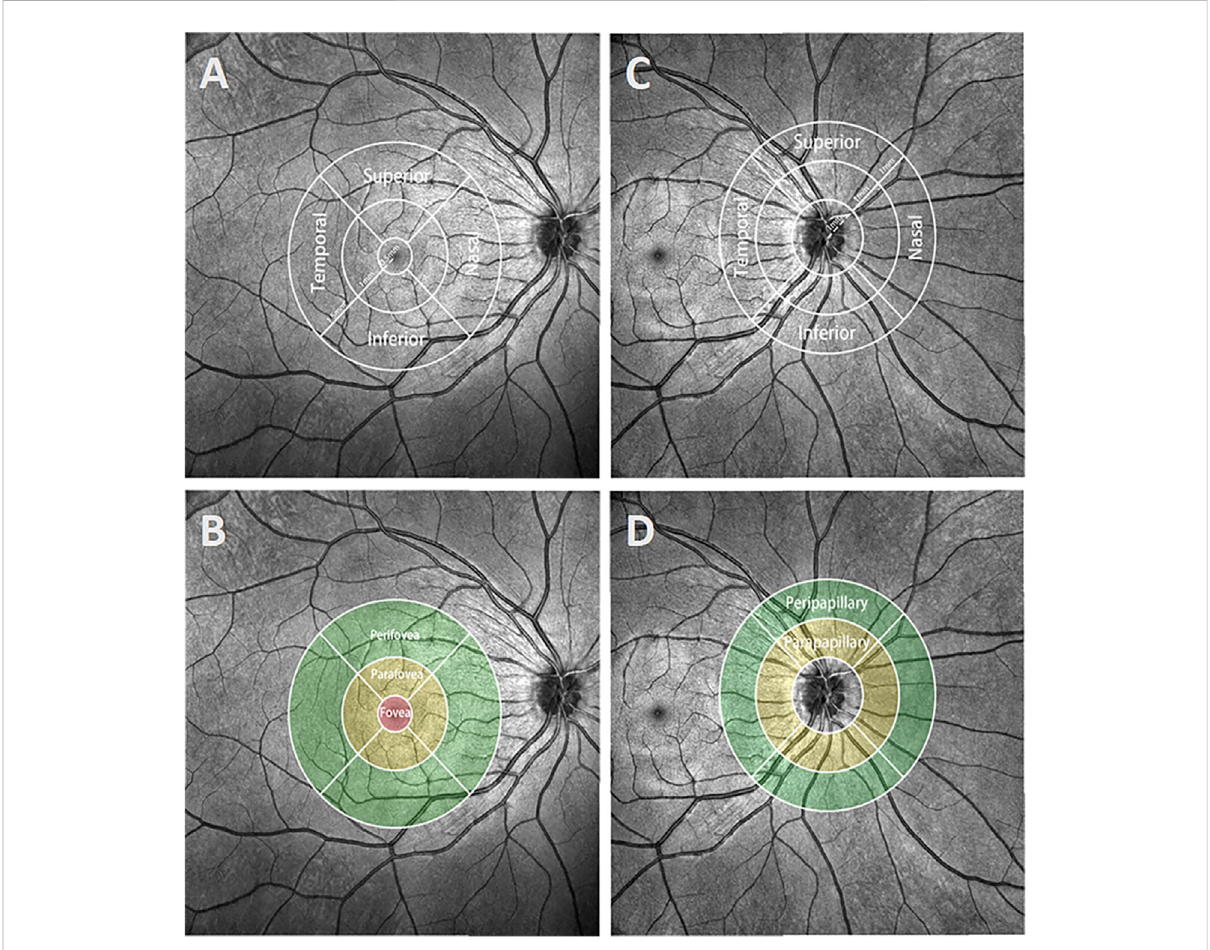
FIGURE 2 Demonstration of different regions and quadrants in the macula and optic disc. (A and B) The ETDRS grid of the macula was separated into regions with diameters of 1 mm (fovea), 1 – 3 mm (parafovea), and 3 – 6 mm (perifovea). The parafovea and perifovea were further divided into four quadrants: superior, inferior, nasal, and temporal. (C, D) The CycleTwo grid of the optic disc was separated into regions with diameters of 2 mm (papillary), 2 – 4 mm (parapapillary), and 4 – 6 mm (peripapillary). The parapapillary and peripapillary regions, like the parafovea and perifovea regions, were also separated into four